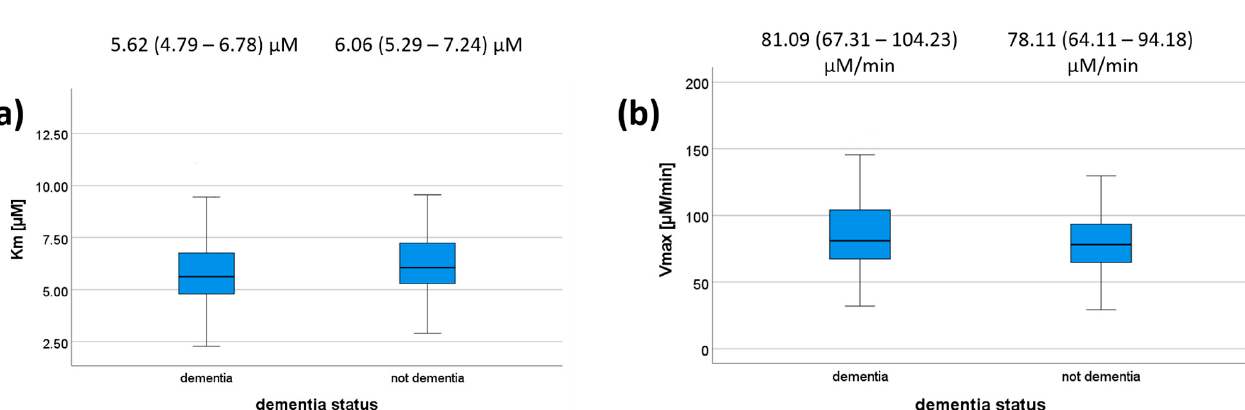
Figure 2. K m ( a ) and V max ( b ) values according to dementia status. The 5-, 25-, 50-, 75-, and 95-percentage intervals are shown. The medians (interquartile ranges) are displayed above each box plot. For ( a ), N (dementia) = 112, N (not dementia) = 82. For ( b ), N (dementia) = 96, N (not dementia) = 63.